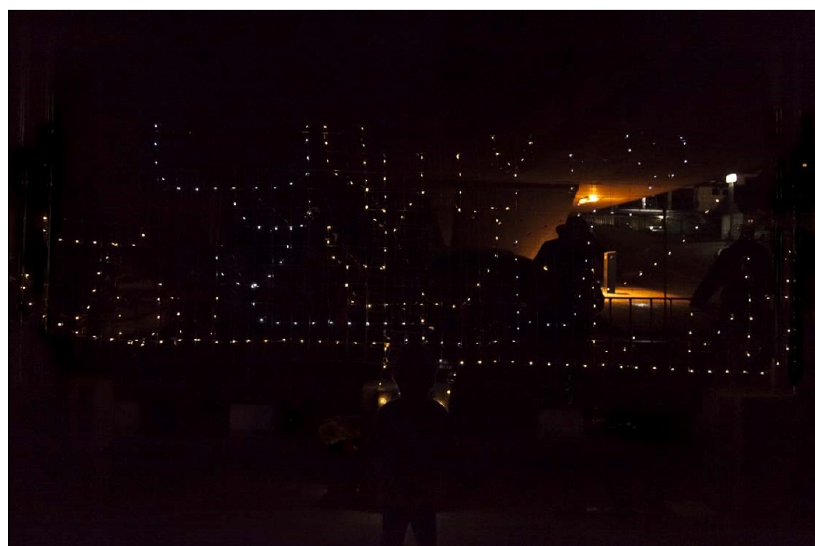
Figure 3. All five participants in sync in ISEA Bright Future (2013).